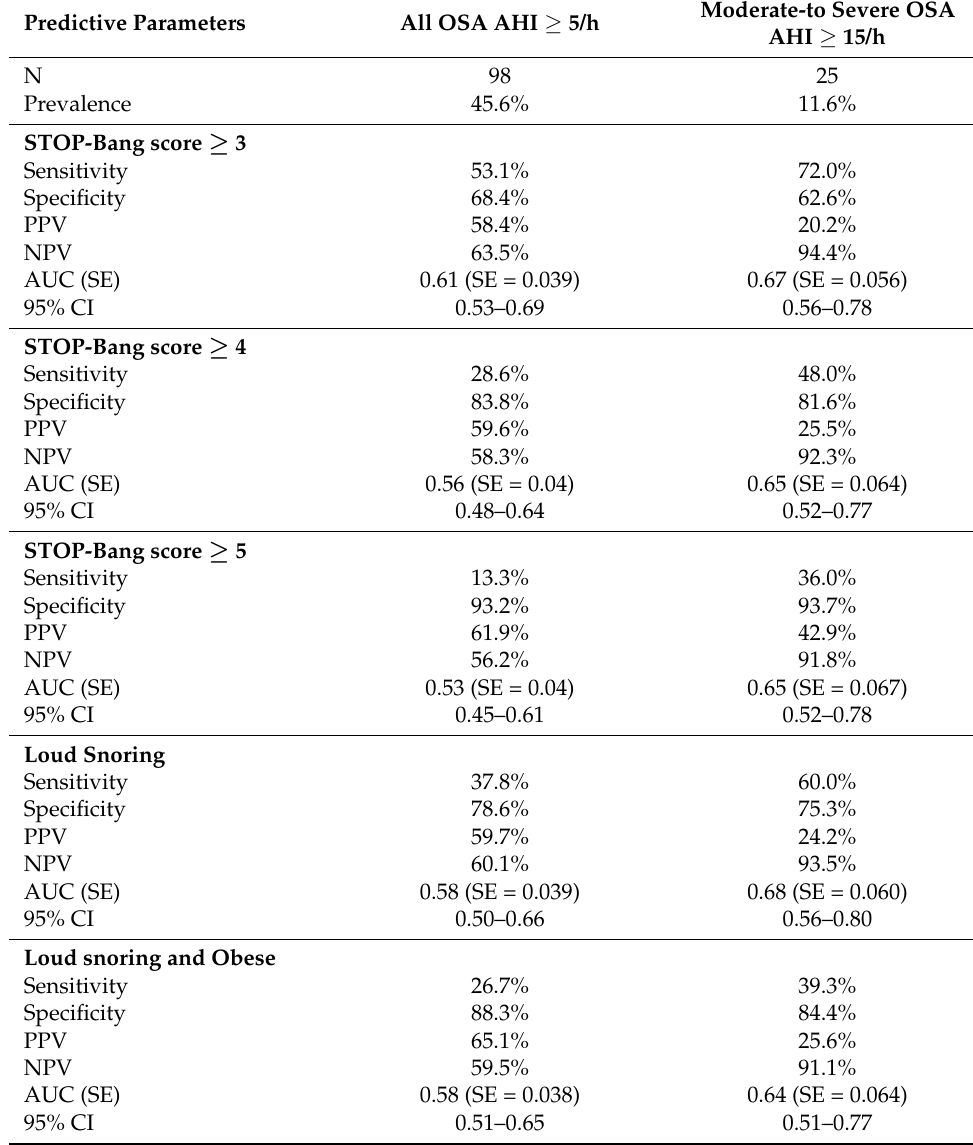
Table 3. Predictive parameters of STOP-Bang score, loud snoring, loud snoring and obese to screen for OSA in First Nations